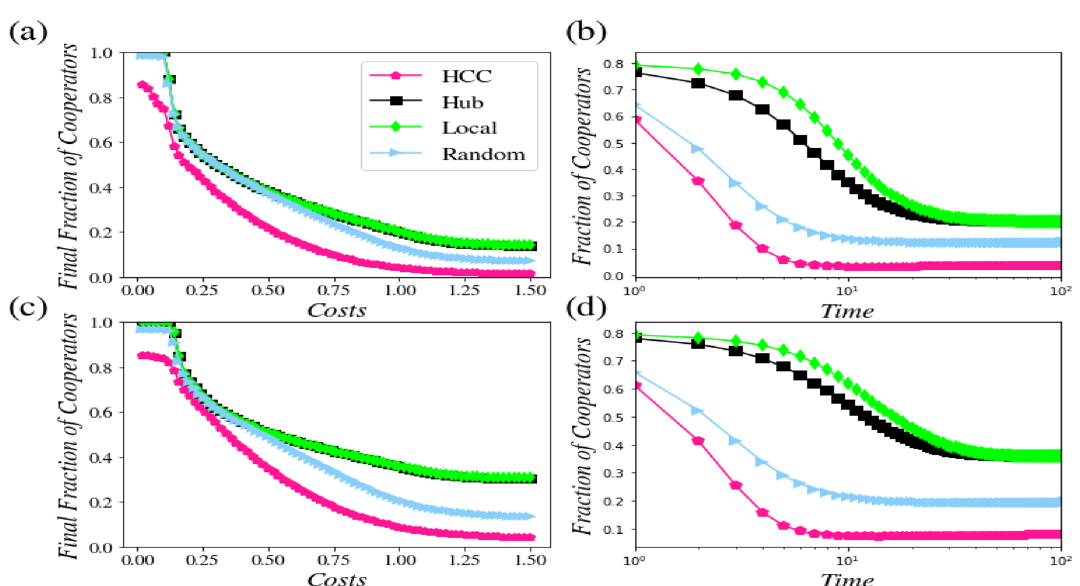
Figure 3. An analysis of the effect of the initial node selection on the network control using the Glauber update rule. The other conditions are as the ones shown in Fig. In Fig. 2, parts a and c display the final cooperation results yielded in the dense and sparse networks. A com- parison drawn between these two networks shows that the denser a network is, the less it becomes cooperative. Indeed, controlling the network towards betrayal is easier if the network is denser. The above conclusions are all based on Monte-Carlo calculations, and averaged out of 20 independent configurations. Figure 3 displays the effect of the Glauber update rule on the level of cooperation in networks. In dense net- works, the effect of the predominance of nodes with the highest control centrality will be easy to observe under